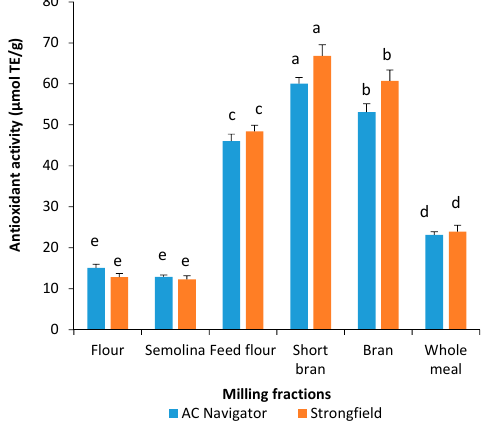
Figure 1. Free radical scavenging activity of total phenolic extracts using acidified methanol on 2,2’-azinobis (3-ethylbenzothiazoline-6-sulfonic acid) (ABTS) radical. Vertical bars represent standard deviations. Different letters indicate significant differences at p < 0.05 for each genotype.